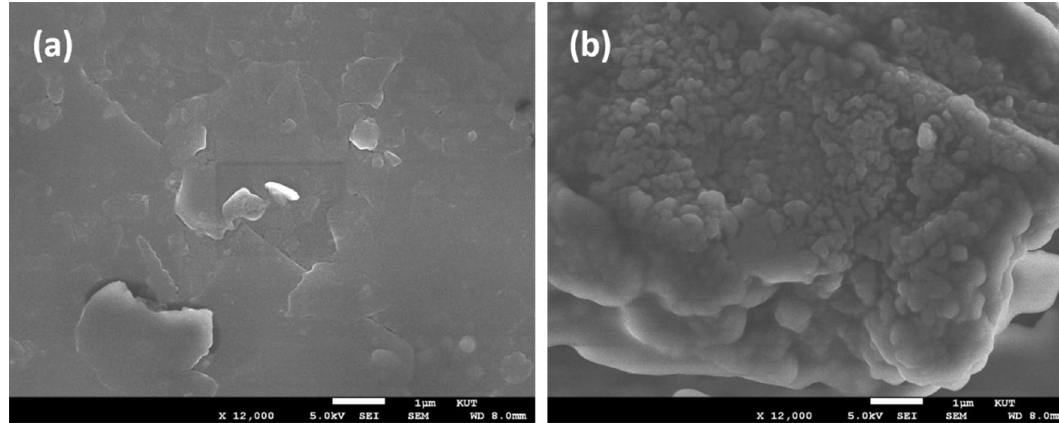
Figure 2. SEM images of bare/CPE ( a ) and polysorbate/CPE ( b